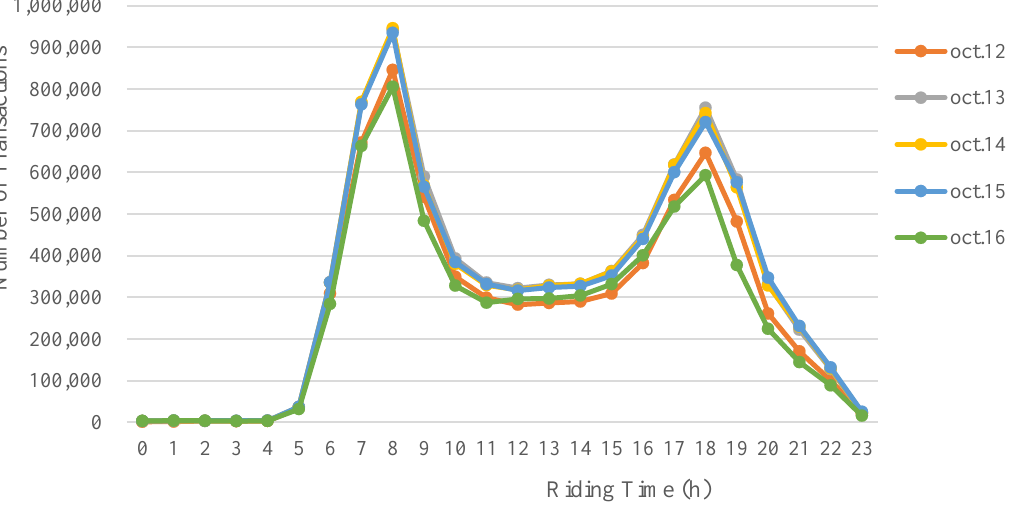
Figure 3. Daily temporal frequency distribution of transactions.